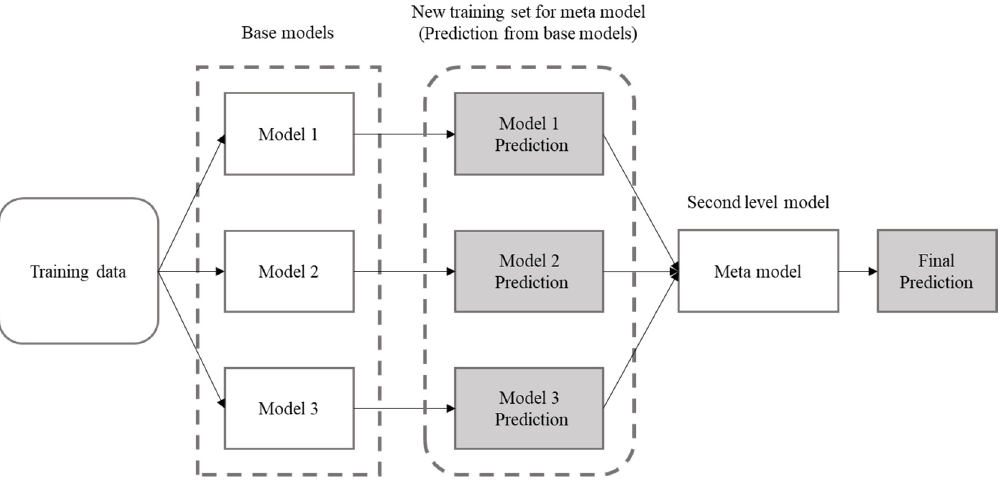
Figure 6. The stacking model.